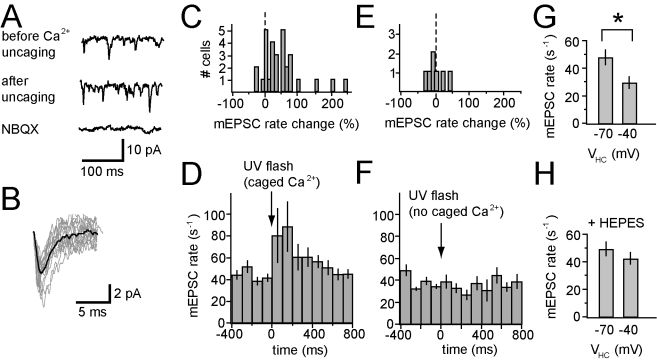
Uncaging Ca2+ in HCs increases glutamate release from
photoreceptors.(A) Spontaneous inward currents recorded from an HC before (top trace)
and after (middle trace) UV flash photolysis of caged
Ca2+ (DM-nitrophen). Uncaging Ca2+
appeared to increase the frequency of mEPSCs. Spontaneous inward
currents were eliminated after blocking AMPA receptors with 10 µM
NBQX (bottom trace), identifying them as glutamatergic mEPSCs. (B)
Average mEPSC waveform used for template matching (dark trace) and 10
individual events that were classified as mEPSCs. (C) Histogram showing
distribution of HCs exhibiting increases or decreases in peak mEPSC rate
after Ca2+ uncaging. (D) Time course of the change in
mEPSC rate after Ca2+ uncaging. The time course reflects
the average mEPSC rate from 31 HCs. (E) Histogram showing distribution
of HCs exhibiting increases or decreases in peak mEPSC rate after UV
flash when DM-nitrophen was absent from the pipette solution. (F) Time
course mEPSC rate after UV flash, in the absence of DM-nitrophen. The
time course reflects the average mEPSC rate from seven HCs. (G)
Depolarization of HCs from −70 mV to −40 mV results in a
statistically significant (p<0.05) decrease in
average mEPSC rate (n = 4). (H)
Depolarization of HCs from −70 mV to −40 mV fails to cause a
significant increase in mEPSC rate after addition of HEPES (10 mM) to
the bathing medium (n = 4).